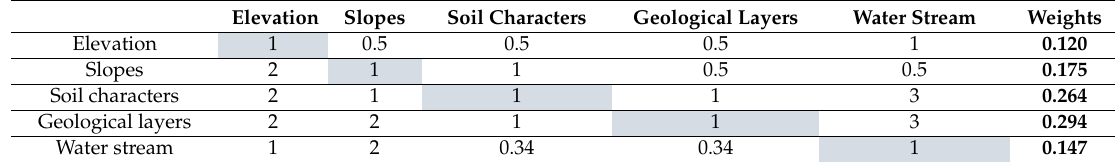
Table 10. Comparison matrix and significance weight of sub- criteria of topography.